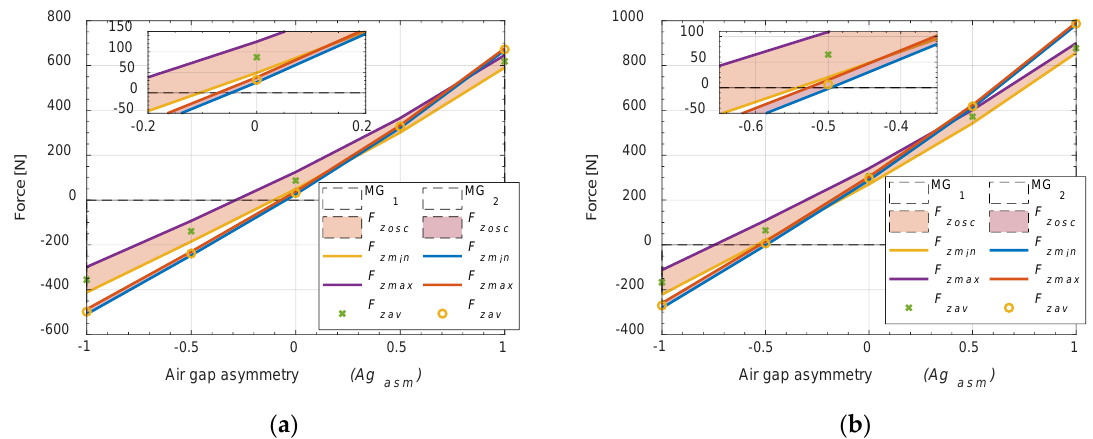
Figure 12. Global force F zTot components acting on whole modulator vs. inner rotor angle and air gap asymmetry, for the two gear variants at ( a ) no load and ( b ) max load (MG 1 and MG 2 ). Table 2. Design parameters for the axial flux magnetic